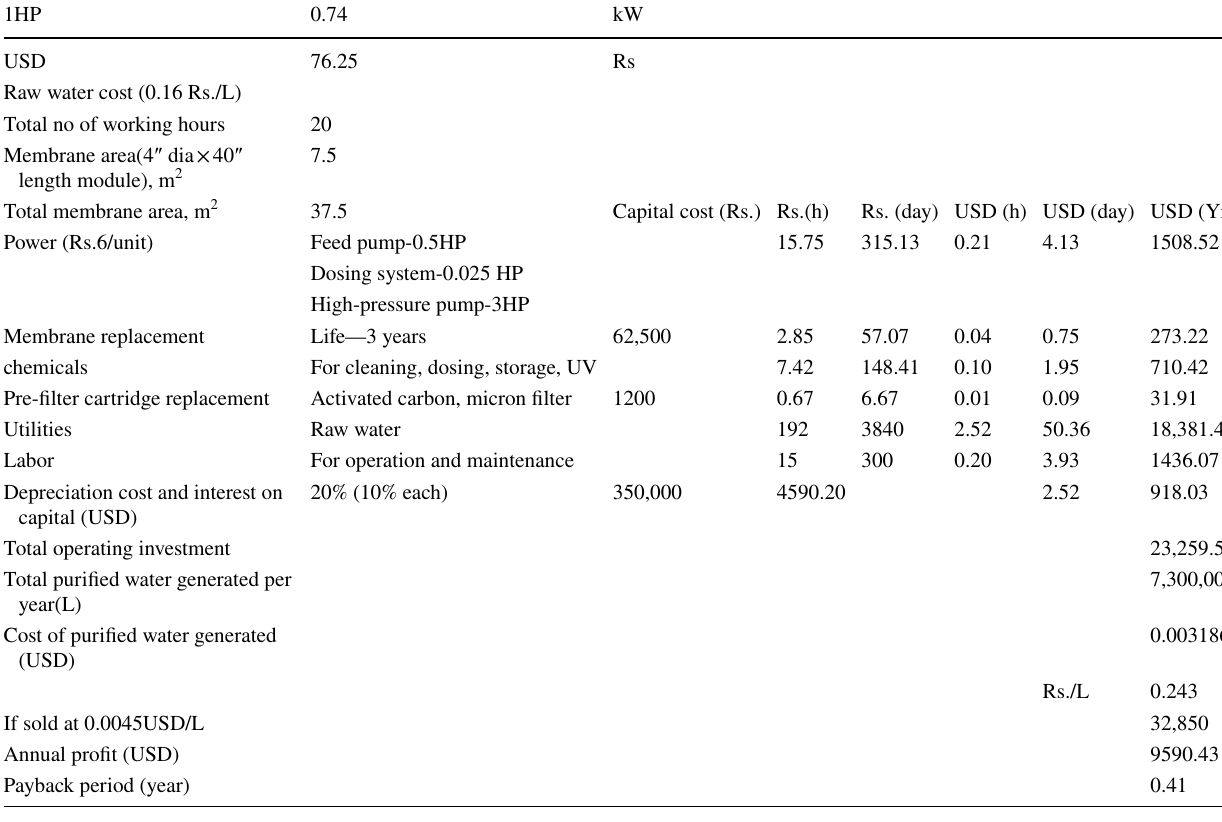
Table 2 Detailed cost estimation for processing of water through modified RO membrane (nanofiltration)